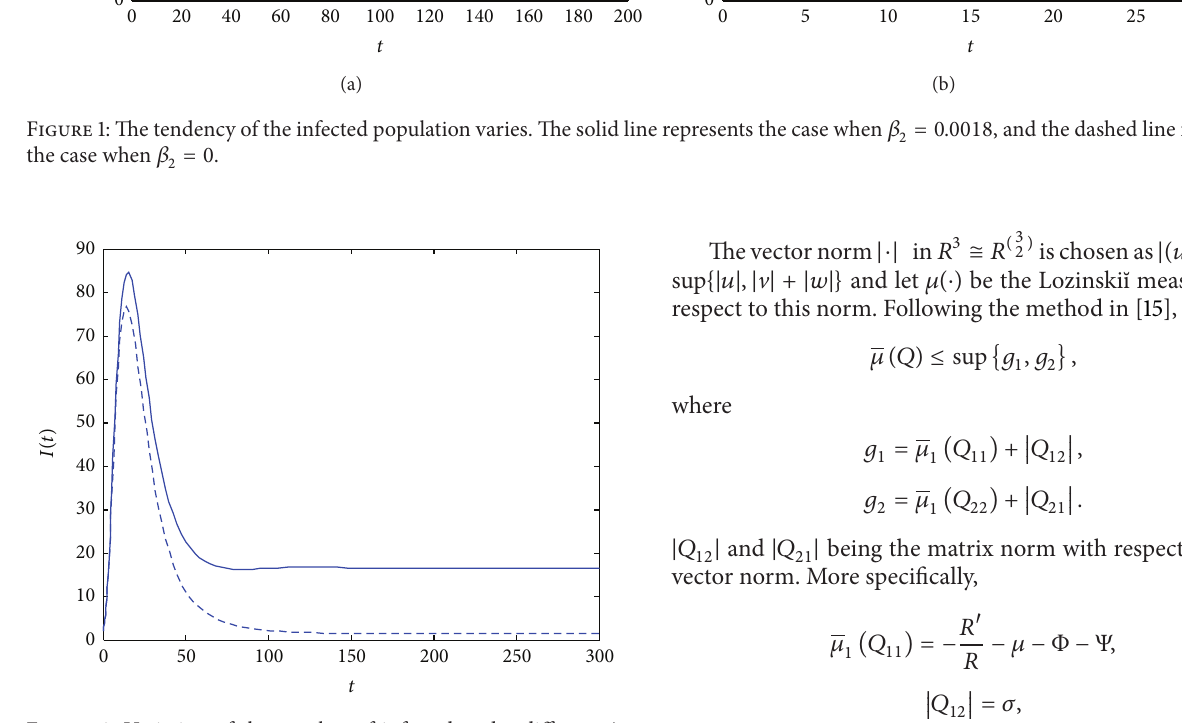
Figure 2: Variation of the number of infected under different Λ . The solid line represents the case when Λ = 5 , and the dashed line represents the case when Λ = 2